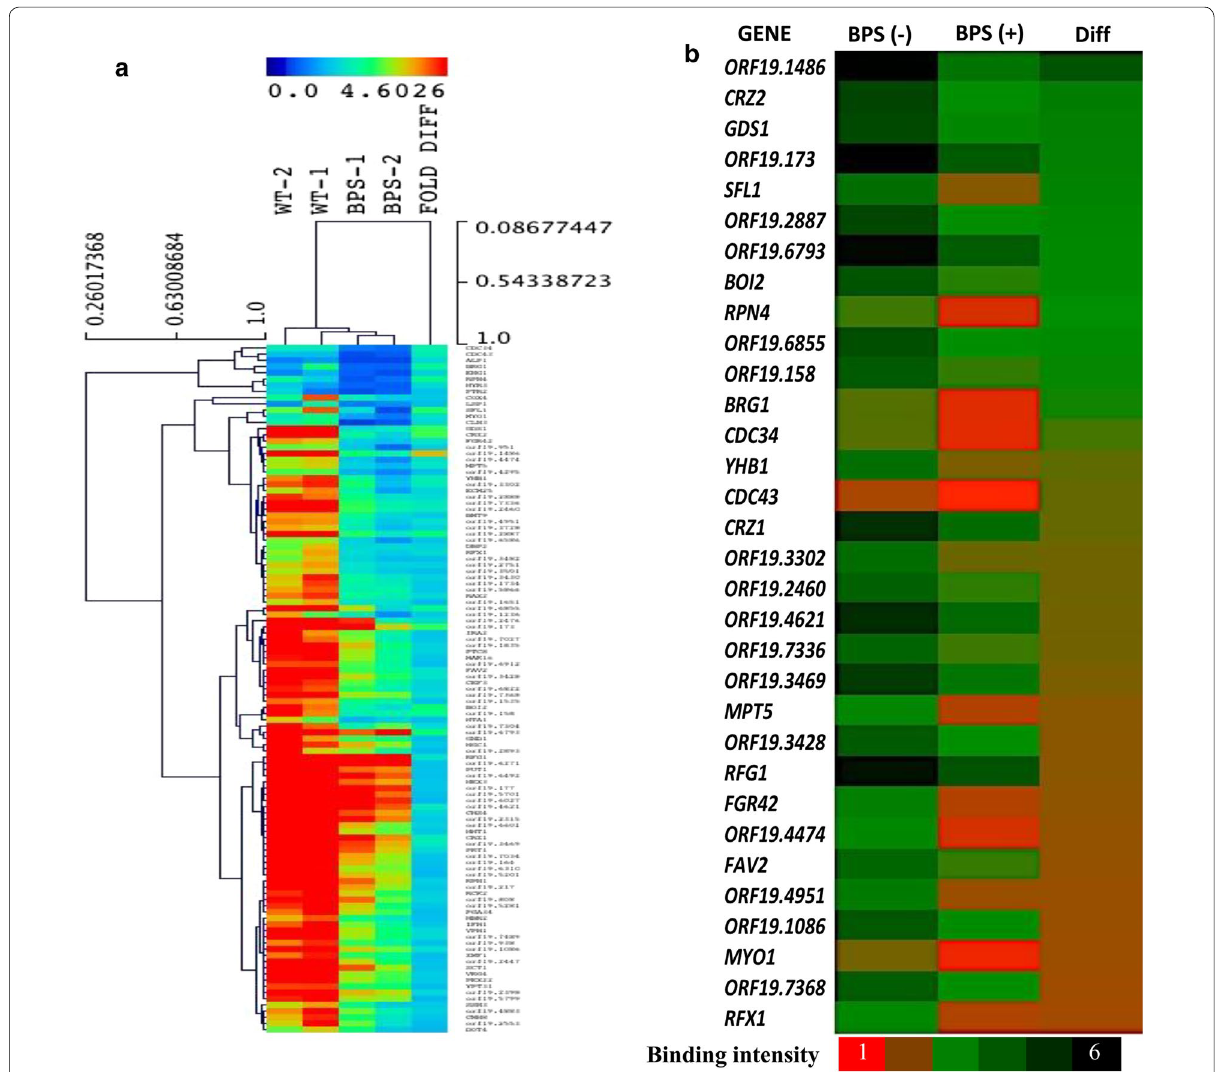
Fig. 8 Comparison of Hsf1 binding intensity under wild-type and iron-deprived conditions. a Differences of binding intensity of genes whose promoters are enriched both under normal and iron deprived conditions using Jalview Software. b The genes which show maximum difference in intensities are represented as heat